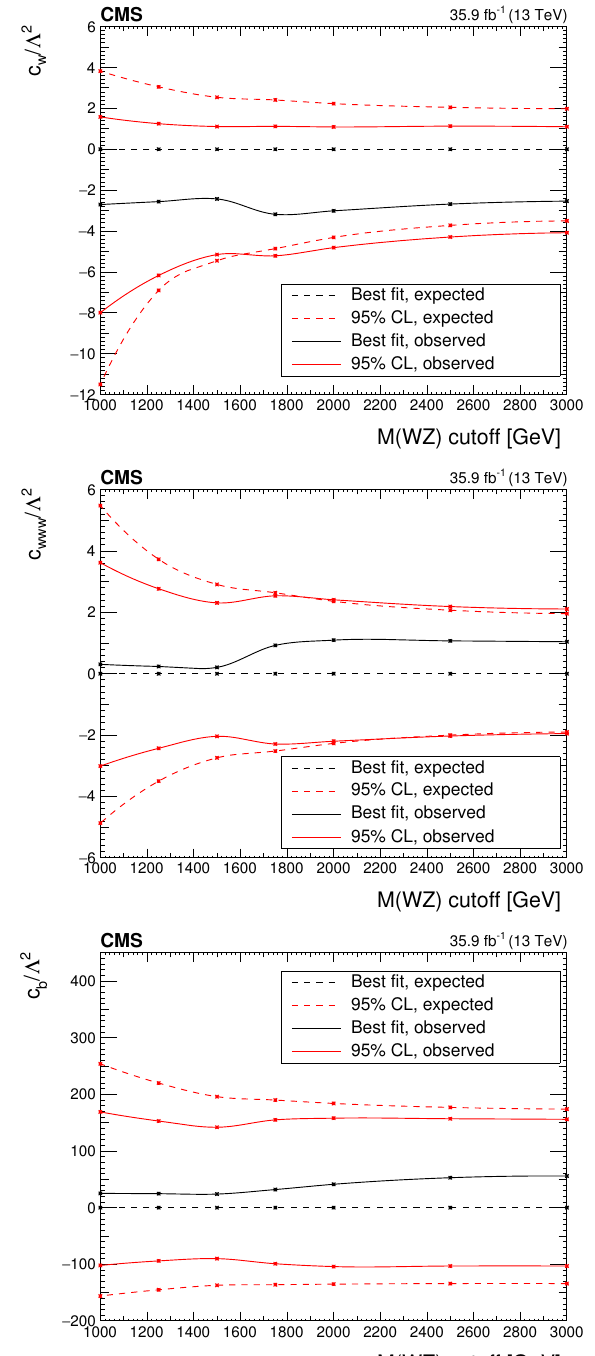
Figure 17 . Evolution of the expected and observed con(cid:12)dence intervals of the EFT anomalous coupling parameters in terms of the cuto(cid:11) scale given by di(cid:11)erent restrictions in the M (WZ) vari- able. For each point and parameter, the con(cid:12)dence intervals are computed imposing the additional restriction of no anomalous coupling contribution over the given value of the M (WZ) cuto(cid:11). The last point is equivalent to no cuto(cid:11) requirement being imposed. The parameters considered are: c W (top), c WWW (middle) and c b (bottom).